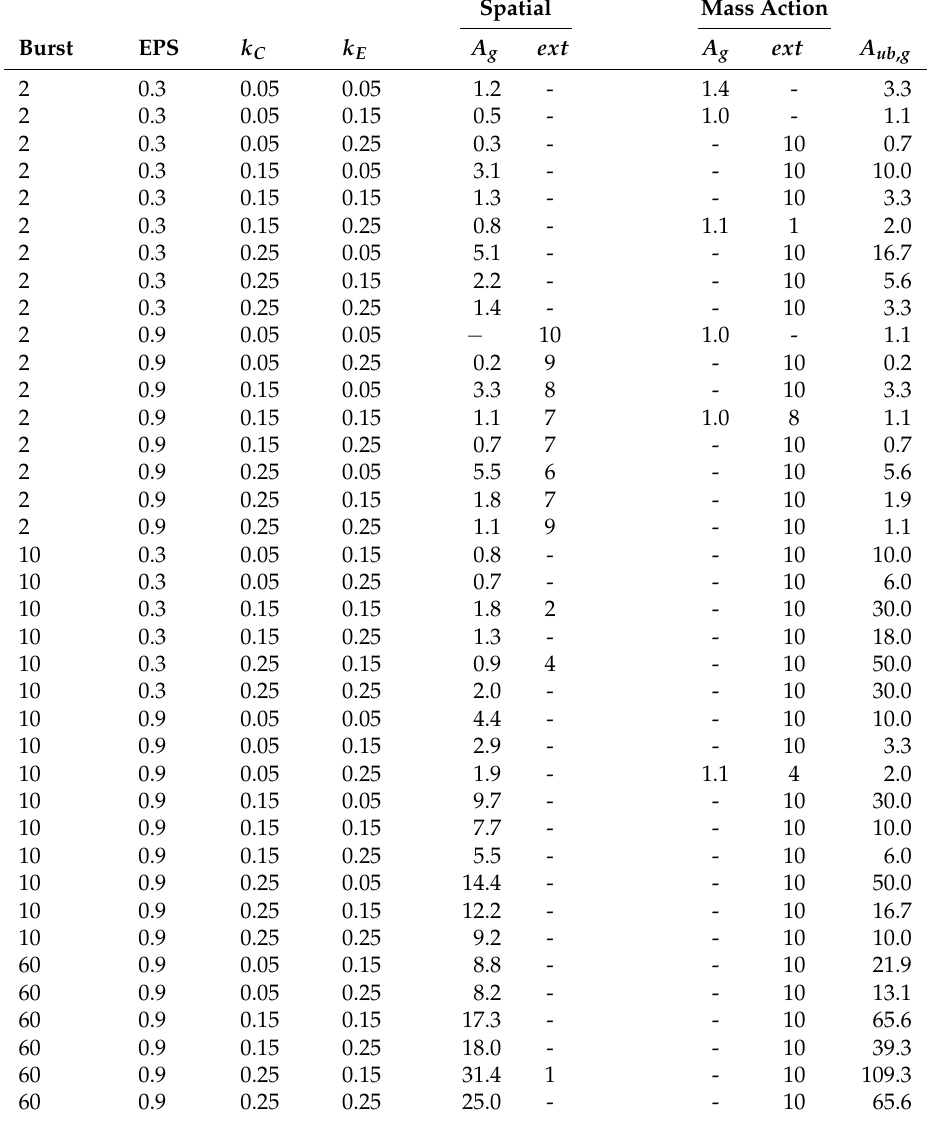
Table 1. Effect of attachment probabilities on cell density in grid models. Spatial Mass